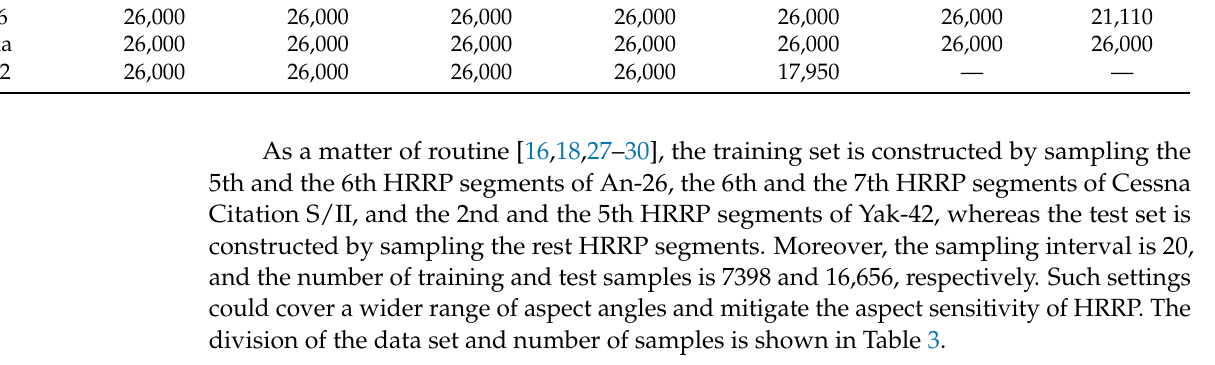
Figure 7. Projections of the trajectories on the ground. ( a ) An-26; ( b ) Cessna Citation S/II; ( c )Yak-42. Table 2. The number of samples for each data segment of the three aircrafts. Aircraft/No.